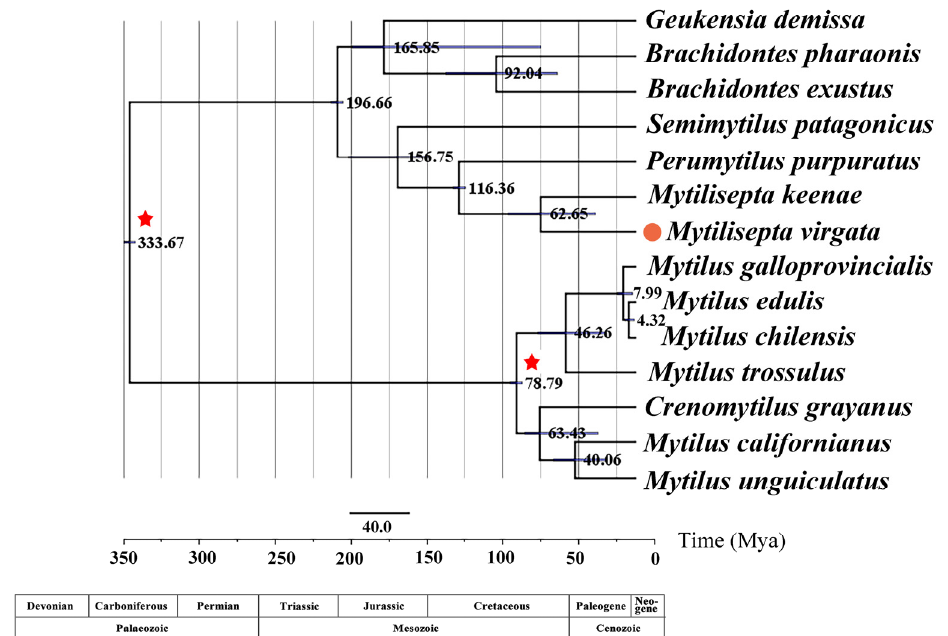
Figure 8. Divergence time estimations for Brachidontinae , Mytilinae , and Mytiliseptinae by using Bayesian relaxed dating methods (BEAST) based on the nucleotide sequences of 12 PCGs (except atp8 ). Horizontal bars indicate 95% relevant nodes and credible intervals of the estimated divergence time. Calibration taxa are indicated with red asterisks on the corresponding nodes, and the orange dot indicates M. virgate in this study.